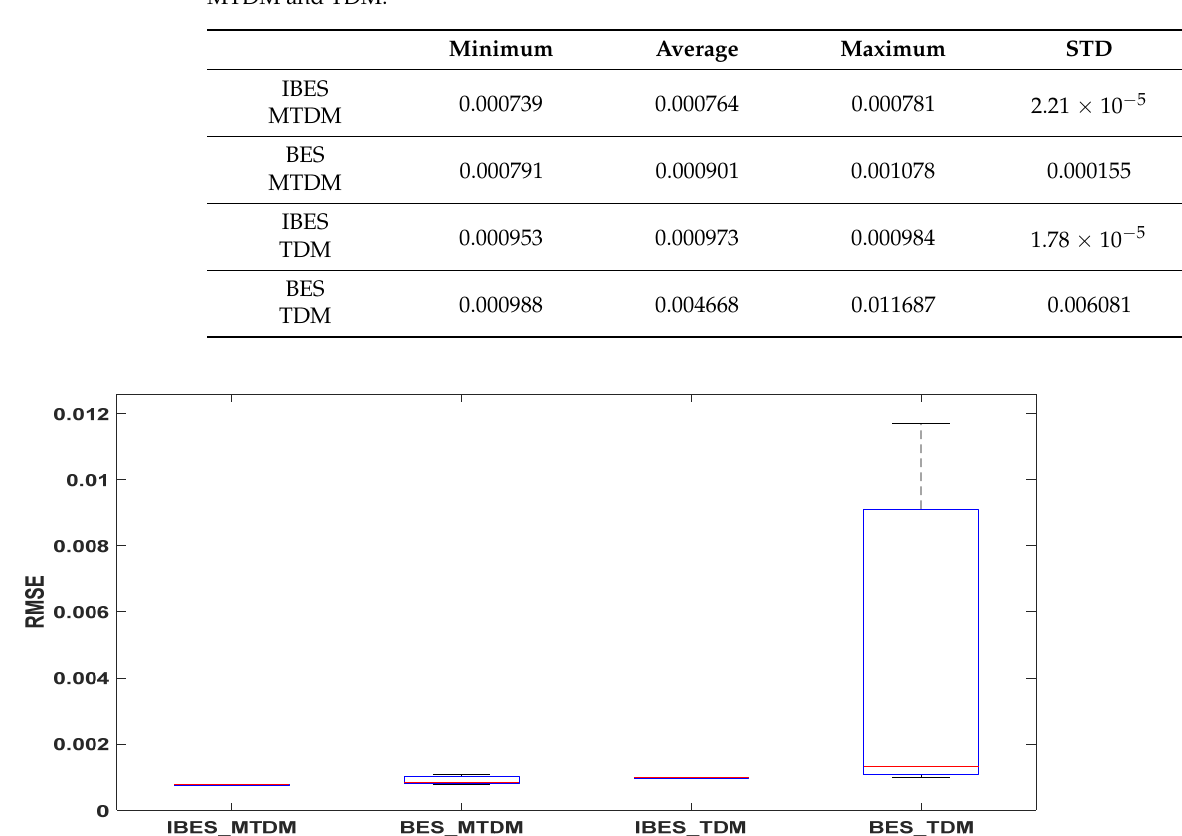
Figure 13. The convergence curves for the IBES and BES for the MTDM. Figure 14. The convergence curves of the IBES and BES for the TDM. Figure 14. The convergence curves of the IBES and BES for the TDM.